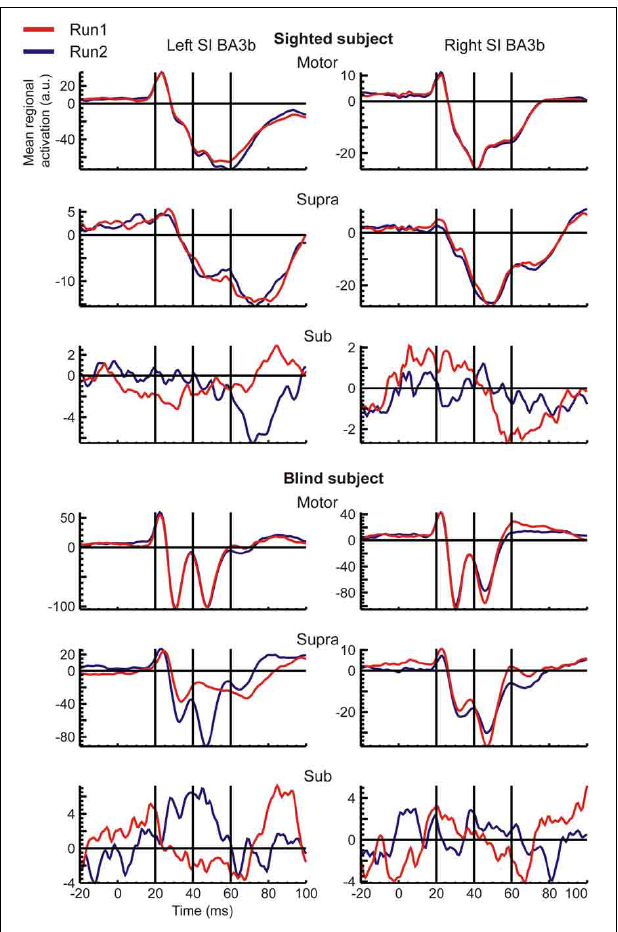
FIGURE 3 | The same as the Figure 2, but for the S2